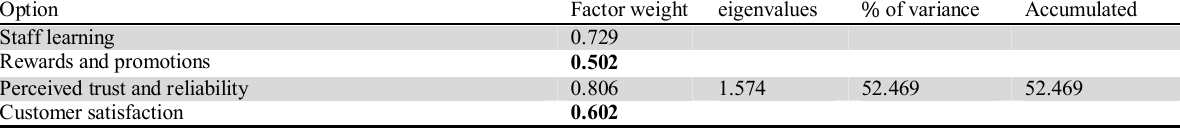
The summary of factors associated with customer relationship management Option Factor